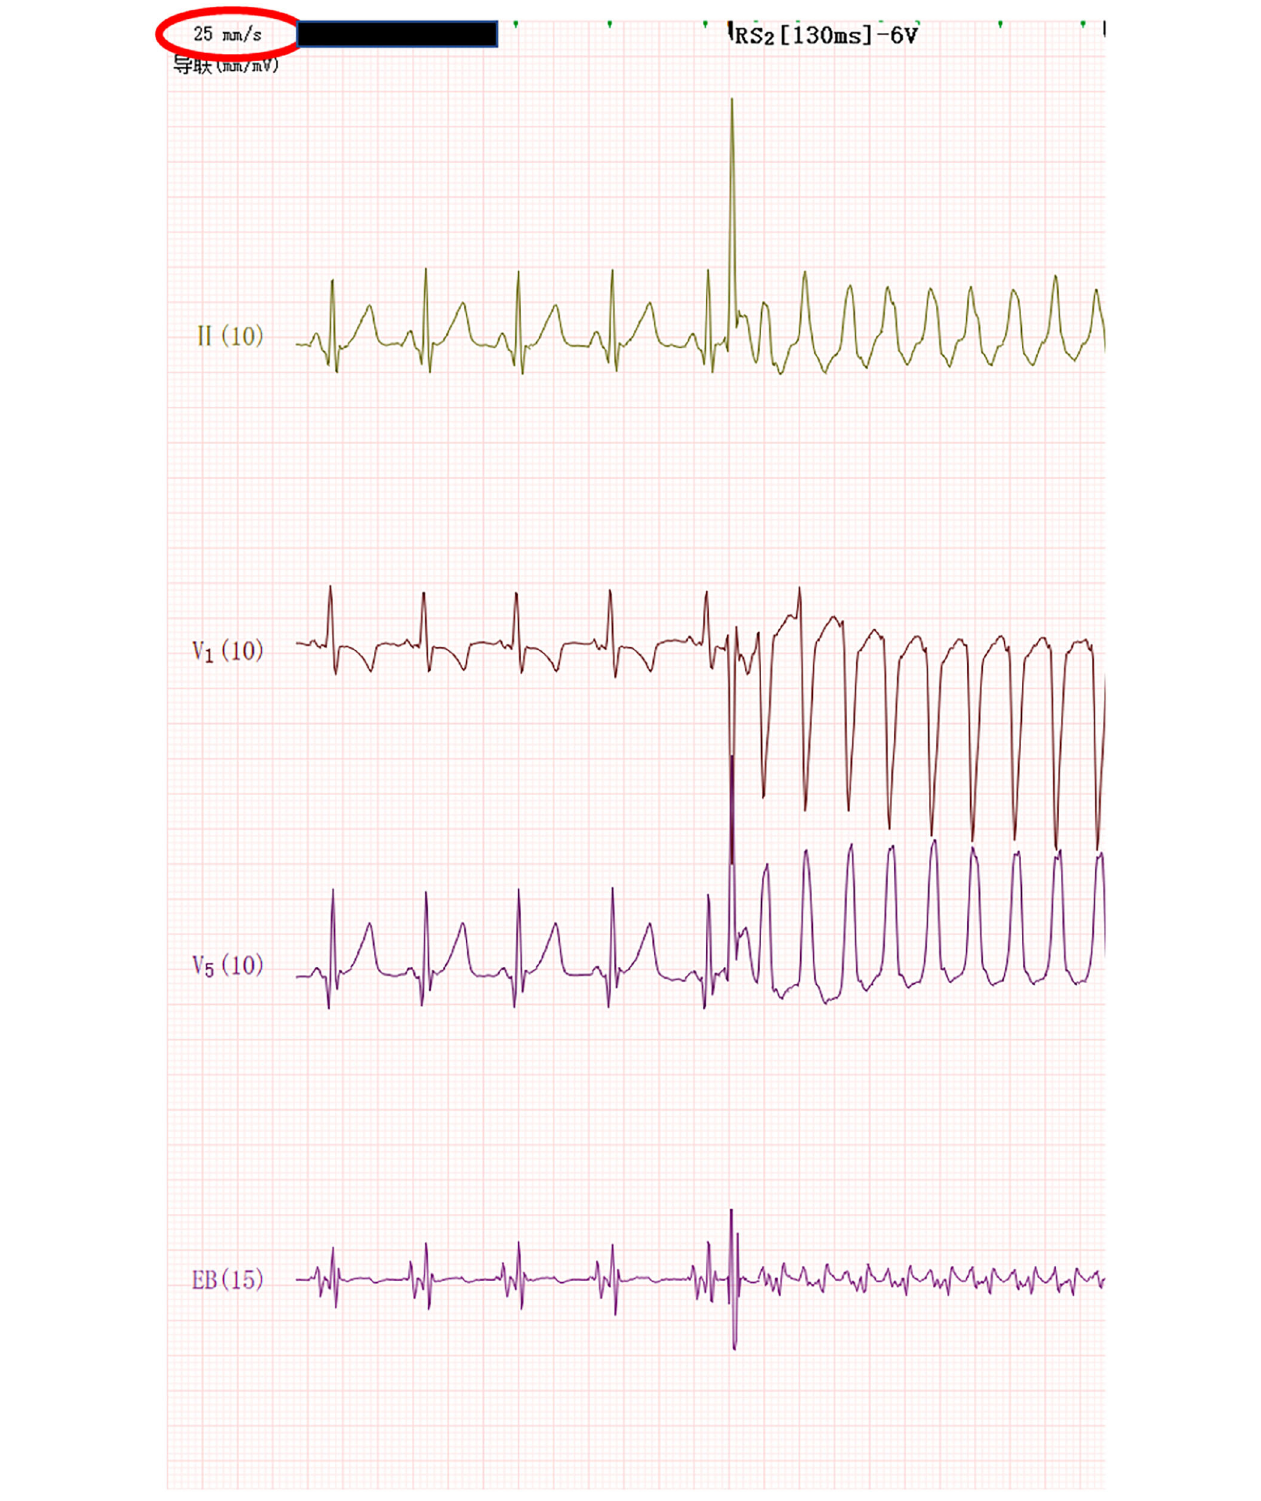
FIGURE 1 | When atrial RS 2 program stimulation reached 130min; the wide QRS tachycardia of the left bundle branch block was induced at 259 bpm.